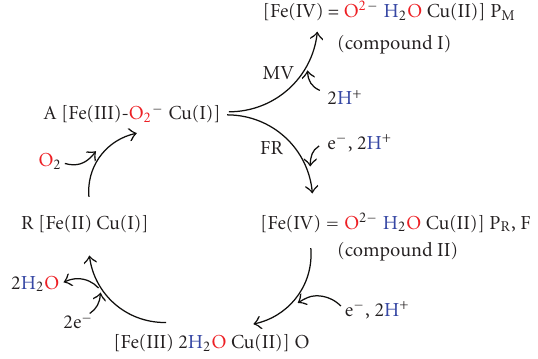
Scheme 1: Schematic representation of pathways of O 2 reduction to produce H 2 O at the catalytic sites of MV and FR C c